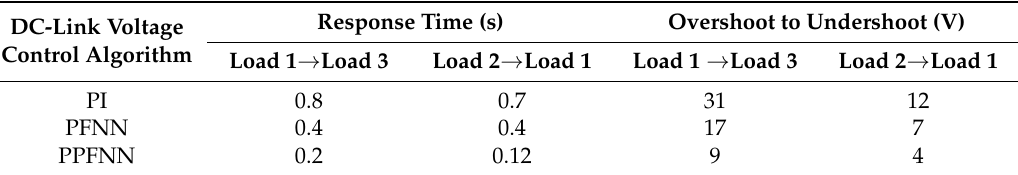
Table 2. Response time of DC-link voltage and maximum DC-link voltage error in transient state using different controllers.